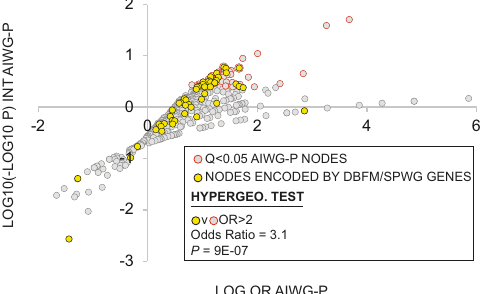
between the nodes conserved upstream of the canonical interferon-stimulated genes I fi t1 , I fi tm3 , and Rsad2 on the one hand, and Rhd on the other. Speci fi cally, nodes upstream of the conserved interferon-stimulated genes comprised members of the STAT and interferon-regulatory families. This was in sharp contrast to the close cross-species-regulatory relationship of Rhd with Tal1 and Gata1, which is consistent with the genomic co-occupancy of these factors [58], as well as their fundamental requirement in the development of hematopoietic lineages [36, 37].